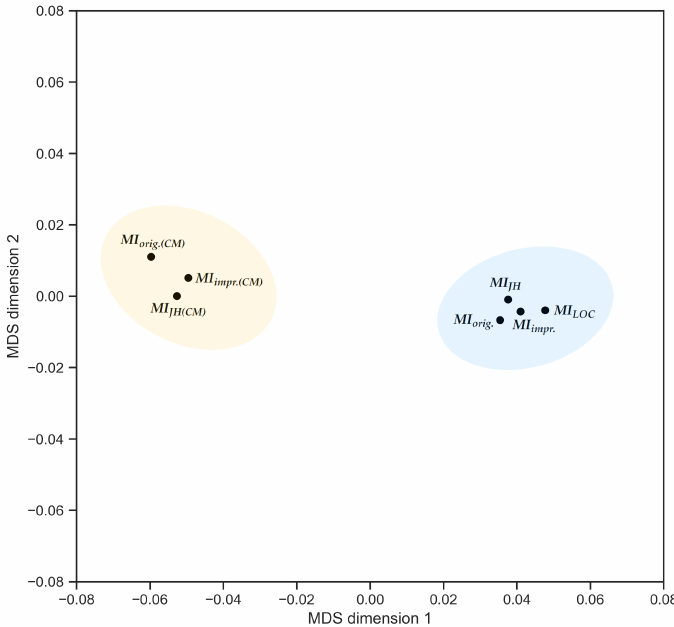
Figure 6. Visualizing similarities and dissimilarities after multidimensional scaling based on the Pearson Correlation